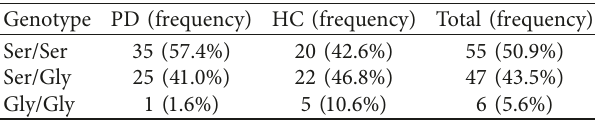
Table 1: Genotype frequencies for DRD3 gene Ser9Gly in PD group and HC group.